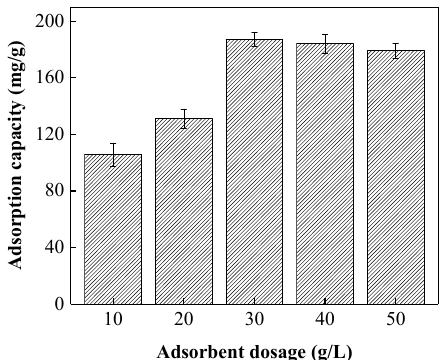
Figure 4. E ff ect of adsorbent dosage on the adsorption of Figure 4. Effect of adsorbent dosage on the adsorption of RB5.